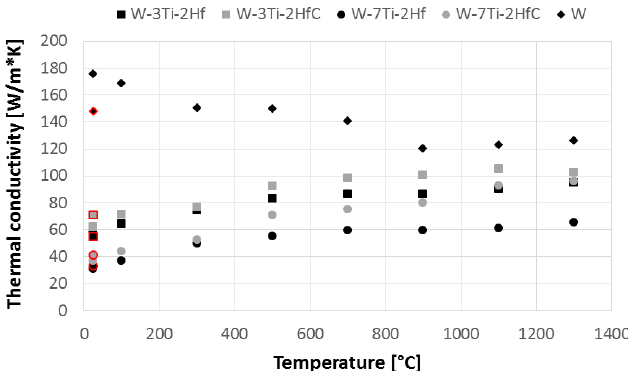
Figure 8. Thermal conductivity of the sintered samples in comparison with properties of sintered pure tungsten; points with red outlines depict the second room-temperature measurement after the high-temperature